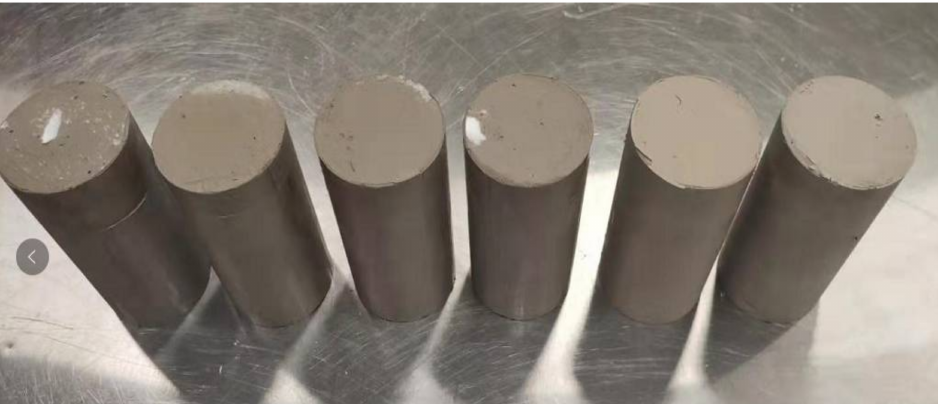
Figure 3. Examples of some cement-stabilised specimens for unconfined compressive strength tests, Port of Brisbane Soft Soil + 5, 10, 15, 20, 25, and 30% cement,